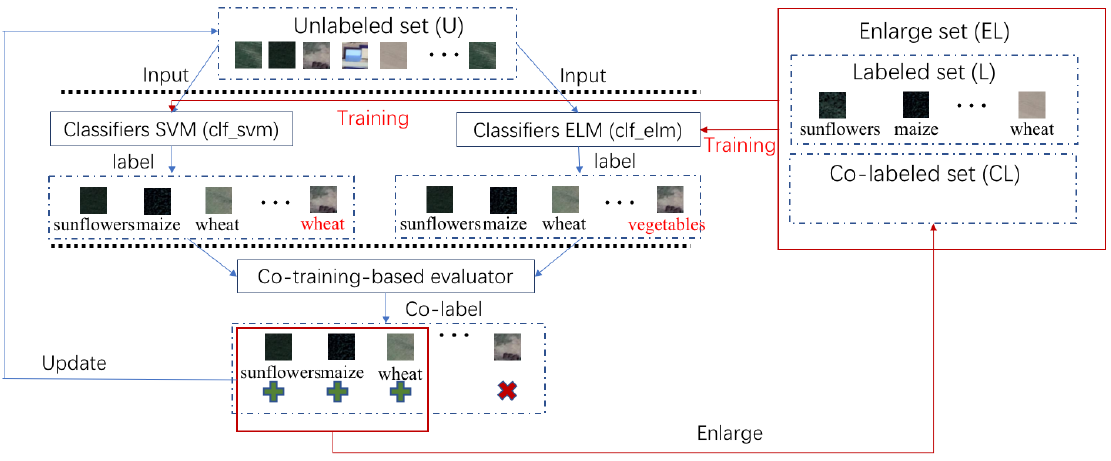
Figure 5. Flowchart of self-label algorithm. Table 2. The procedure of the co-training self-label algorithm (CTSLAL).